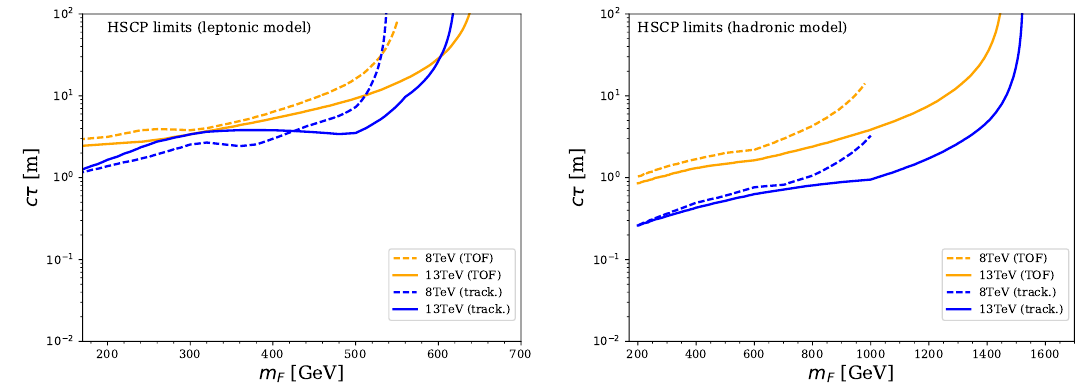
Figure 3 . Region in the c(cid:28) vs m F plane excluded at 95% C.L. by the CMS 8 TeV (18.8 fb (cid:0) 1 ) and 13 TeV (12.9 fb (cid:0) 1 ) HSCP searches. Left: exclusion for the lepton-like scenario. Right: exclusion for the quark-like